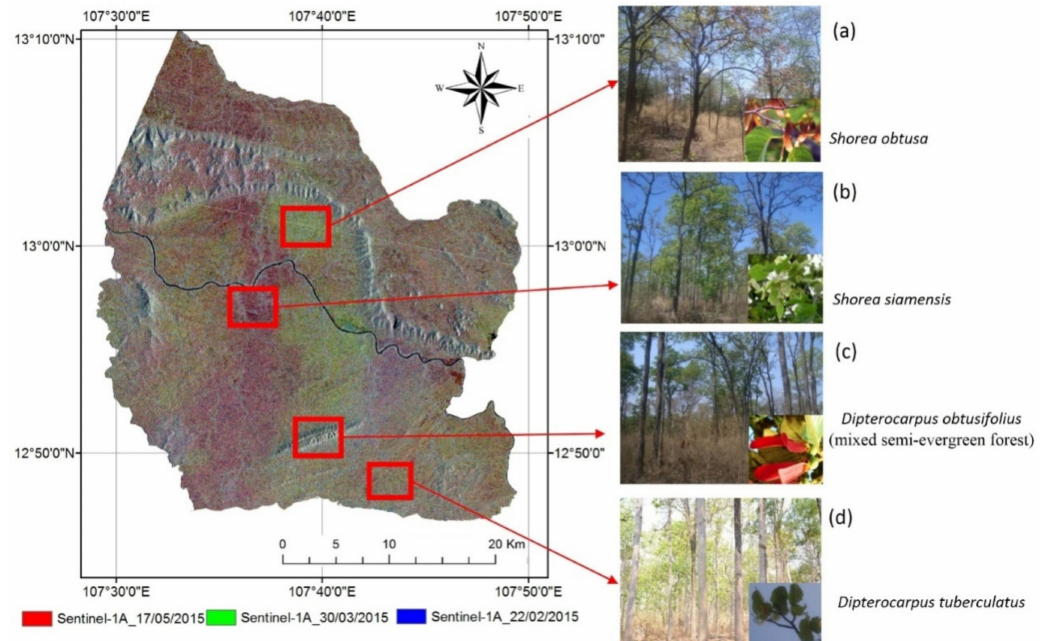
Figure 5. Analysis of deciduous forest species in the composite image: ( a ) Shorea siamensis , ( b ) Shorea obtusa , ( c ) semi- evergreen/evergreen , and ( d ) Dipterocarpus